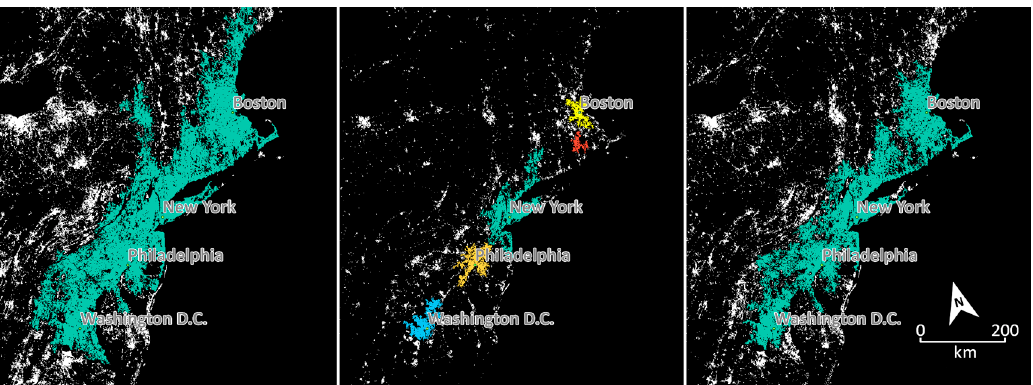
Figure 3. Threshold options for the population density layer. From left to right: 33, 360 and 65 people/km. The largest patch is in green; other colors denote spatially separate large metropolitan areas (blue: Washington D.C., orange: Philadelphia, green: New York, red: Providence, yellow: Boston).